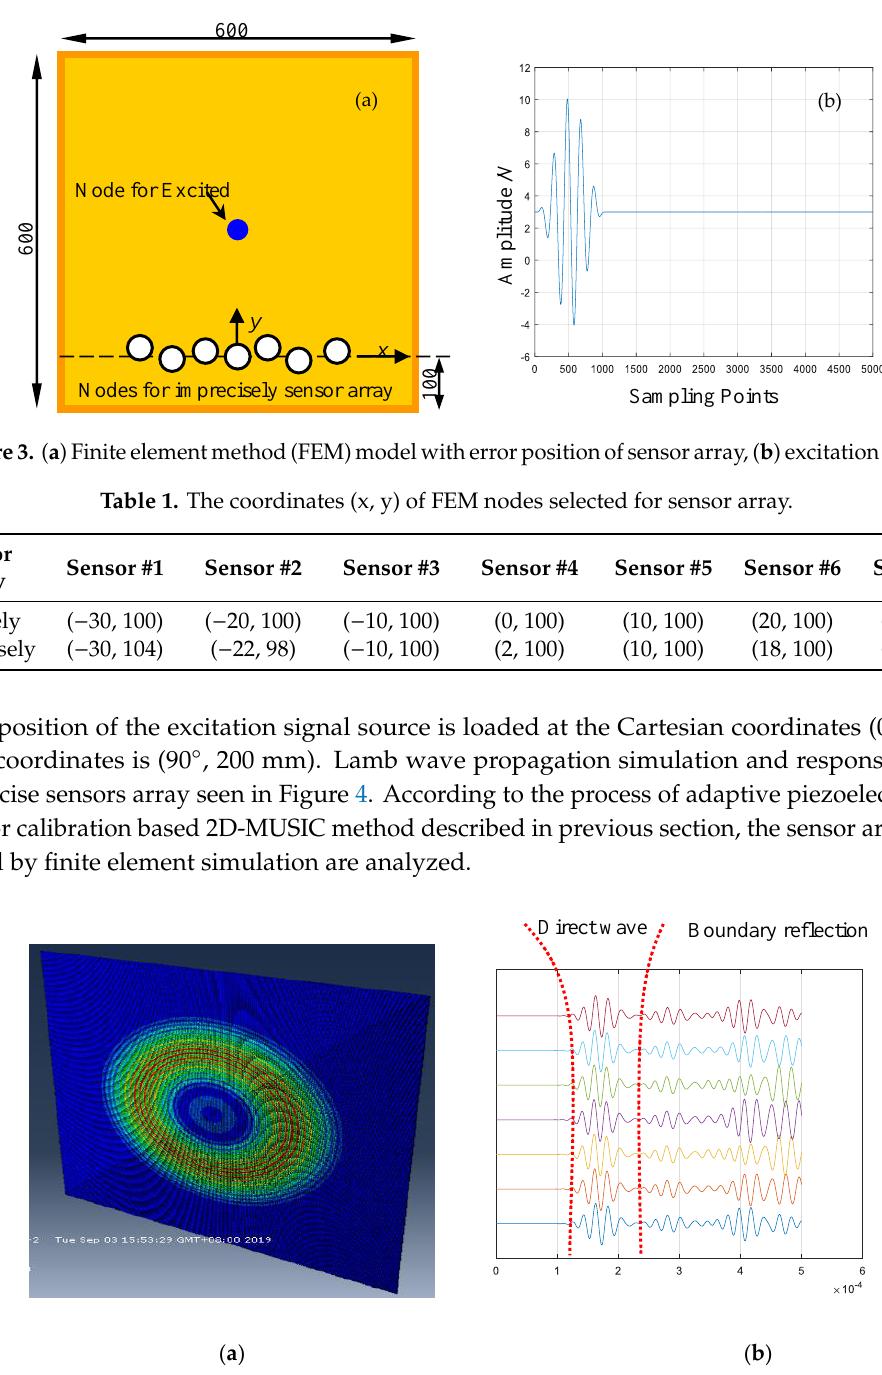
Figure 4. ( a ) Lamb wave propagation simulation and ( b ) response signal of the imprecise sensors